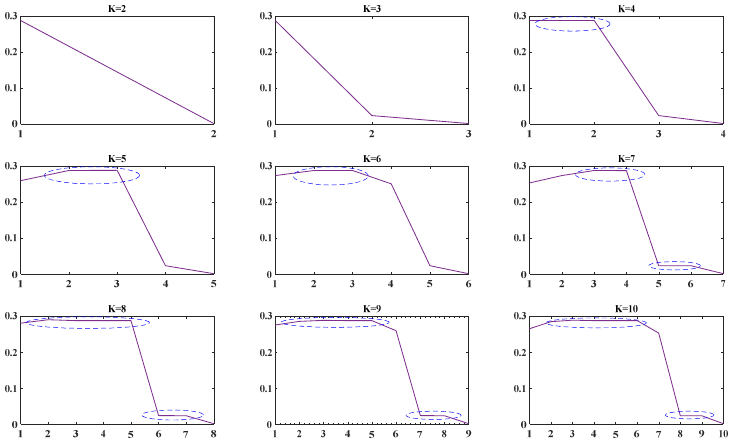
Figure 2. Variation of the mean values of the instantaneous frequencies of the components corre- sponding to different moduli.